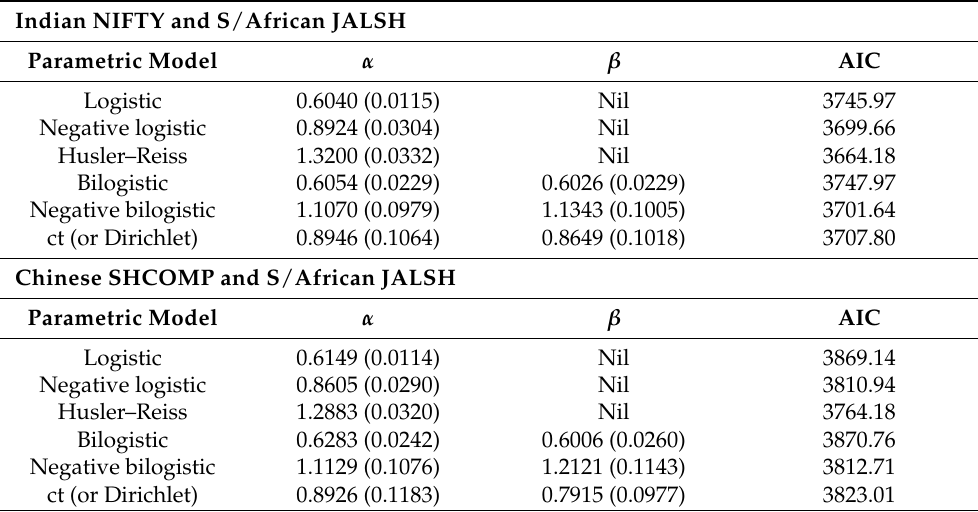
Table 7. Estimates of the point process dependence